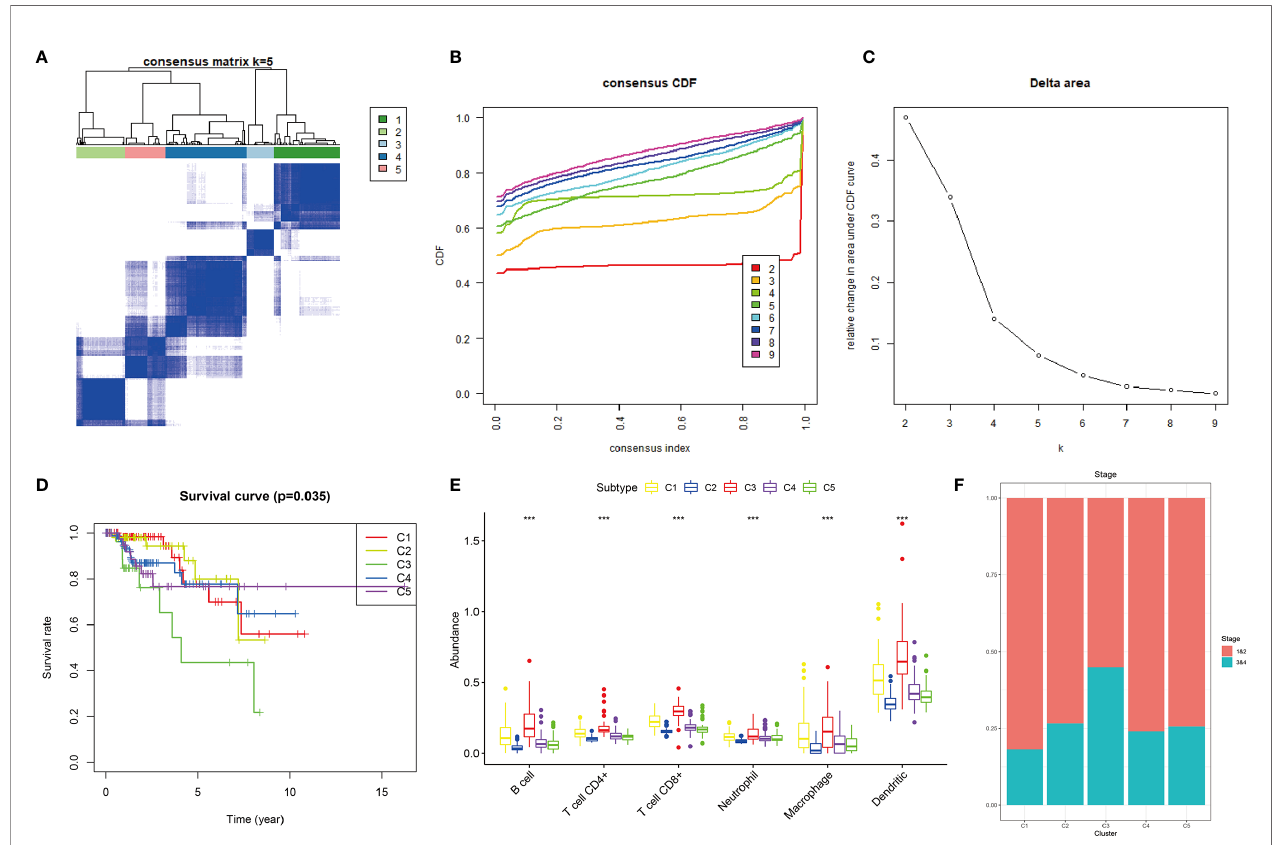
FIGURE 5 | Consensus clustering of KIRP samples in the TCGA cohort. (A) Heat map of sample clustering at k = 5. (B) Cumulative distribution function CDF curve for k = 2 – 9. (C) Relative change in area under the CDF curve when k = 2 – 9. (D) Survival curve of fi ve immune subtypes. (E) The abundance of six immune cells among fi ve immune subtypes, ***p < 0.001. (F) Histogram of tumor stages of fi ve immune